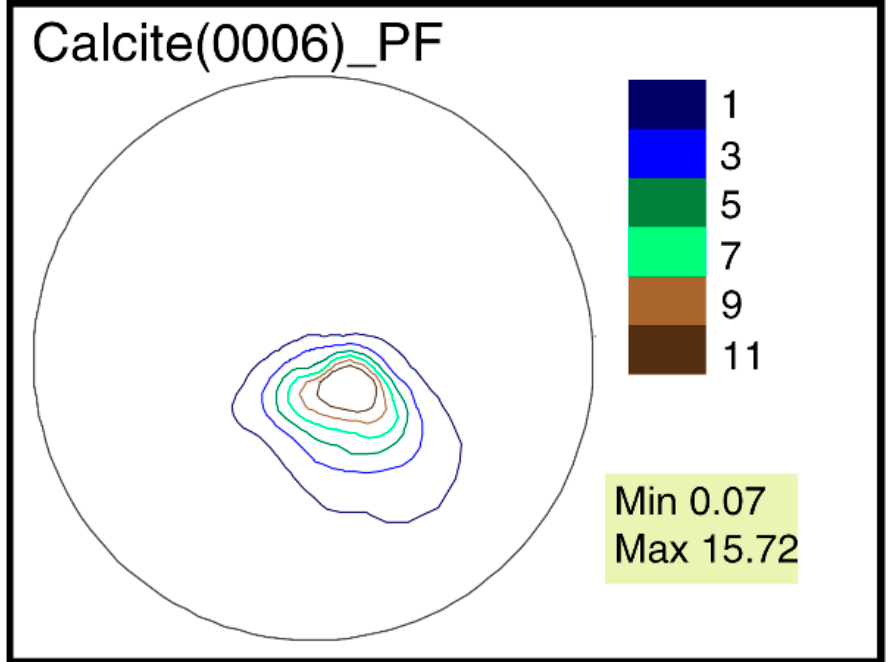
Figure 7. Calcite pole figure (0006) of the valves of Mytilus galloprovincialis Lamarck, 1819, Tuzla Spit, Kerch Strait, Pleistocene, Karangat deposits.